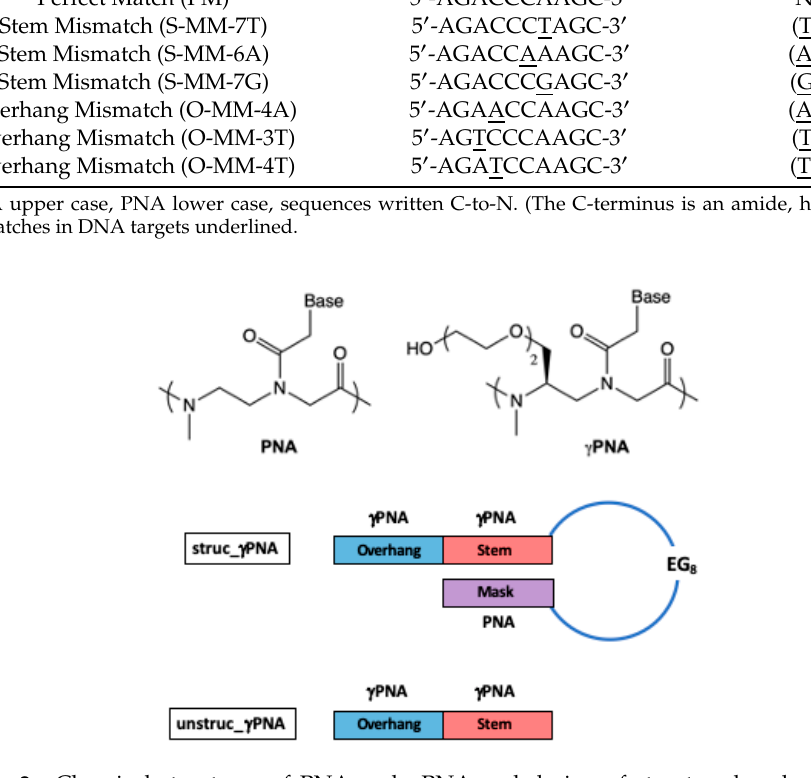
Table 1. GammaPNA ( γ PNA) probes and DNA